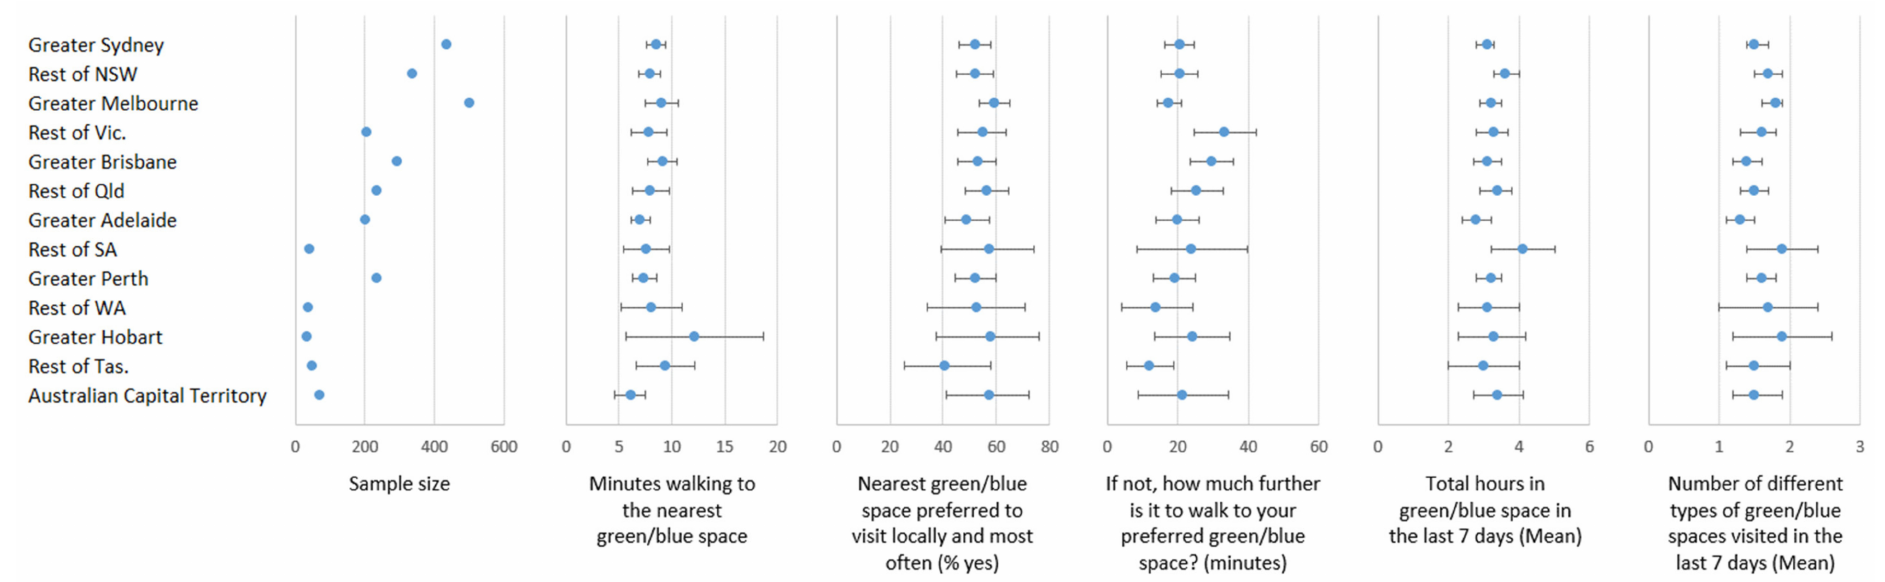
Figure 1. Geographical differences in access to and visitation of the nearest and preferred green or blue spaces during the COVID-19 pandemic (weighted for representativeness, unadjusted for